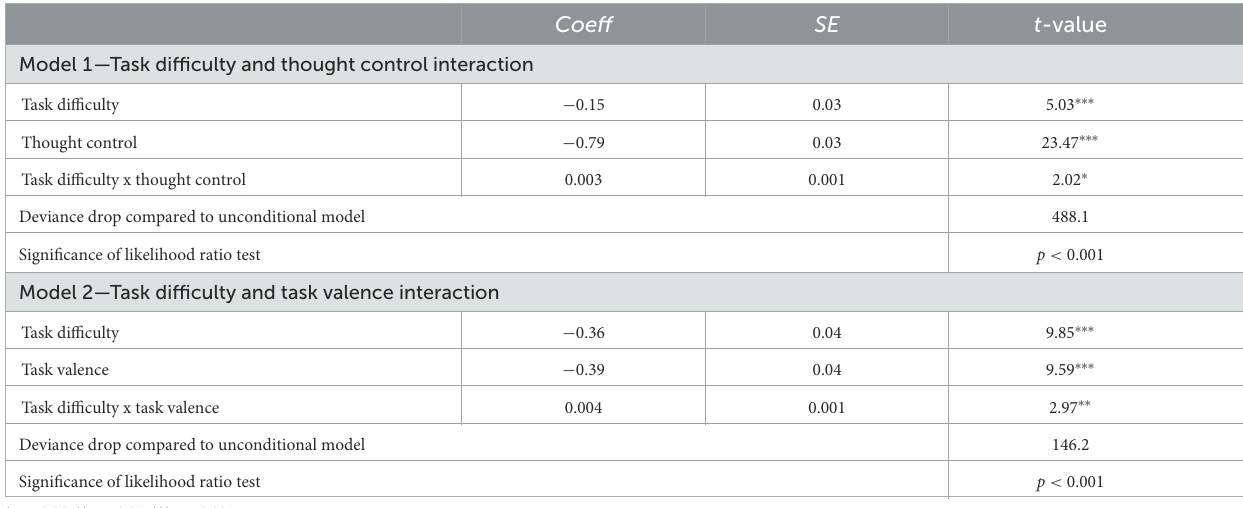
TABLE 2 Testing level 1 predictors and their interactions link to momentary TUT